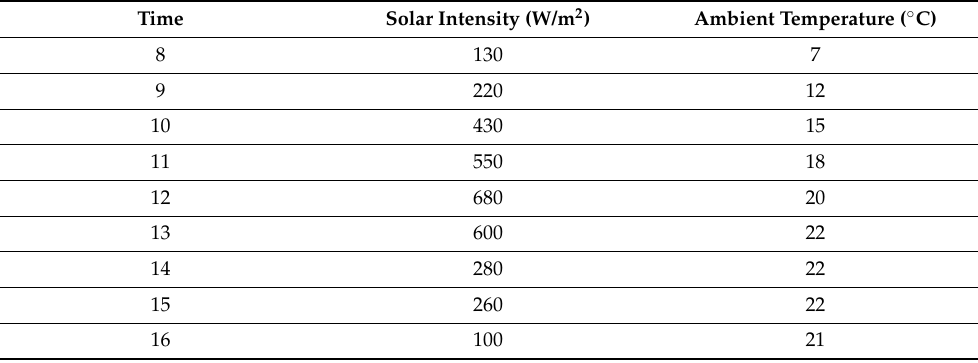
Table 5. Table 5. Weather conditions of the PVT air collector Table 5. Weather conditions of the PVT air collector [44].